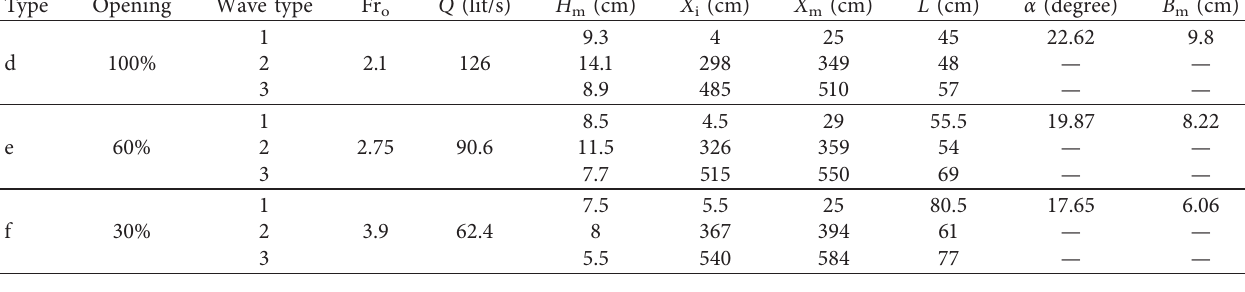
Table 2: The shockwaves’ flow characteristic for four middle gates’